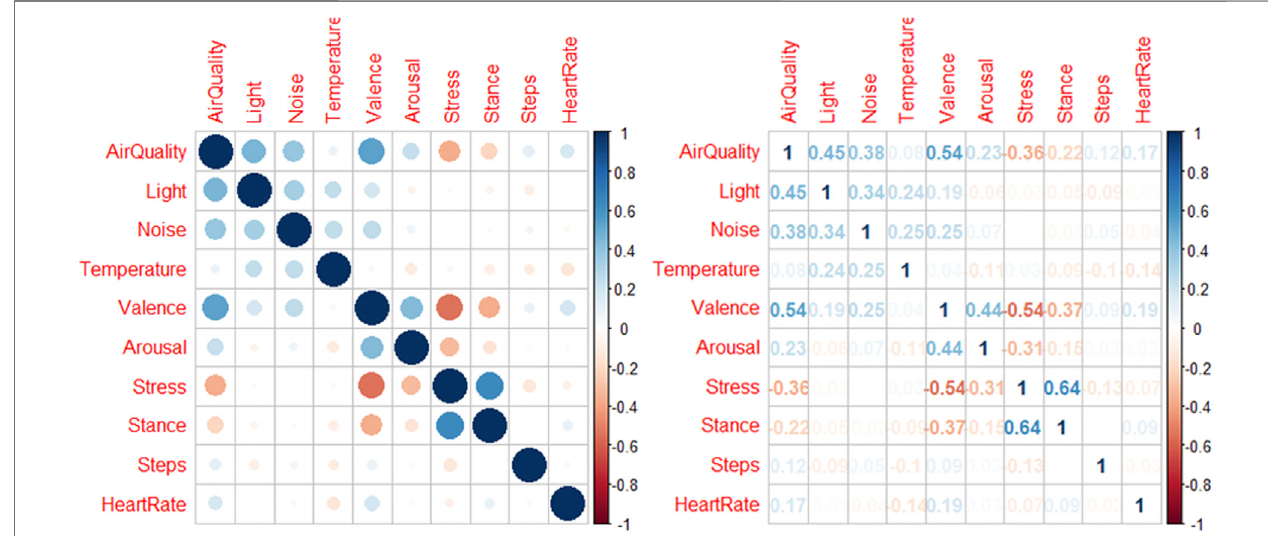
FIGURE 7 | Correlation coefficients for mood and environmental